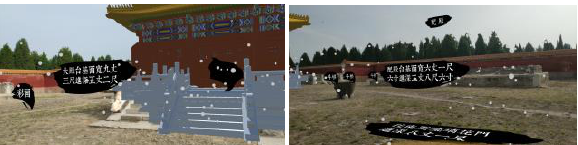
Figure 43. The data of Yangshi Lei Archives appears by clicking the button